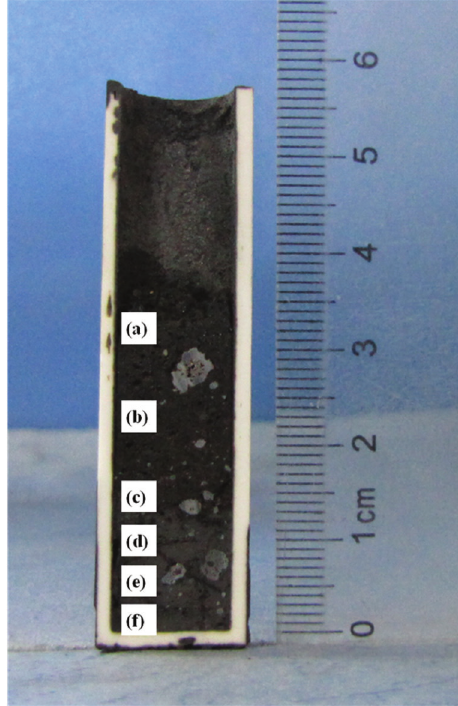
Fig. 3: Cross-section of the samples obtained by centrifugal concentration compared with the parallel sample: (a) G = 1, t = 30 min, T = 1523 K; (b) G = 1050, t = 30 min, T = 1523 K.